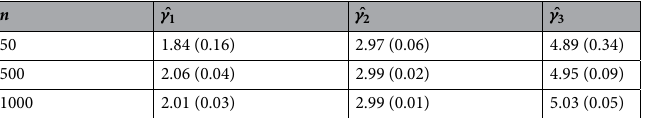
Table 3. The estimated values and corresponding standard deviations in brackets of the estimator γ ( γ 1 , γ 2 , γ 3 ) T . ˆ = ˆ ˆ ˆ